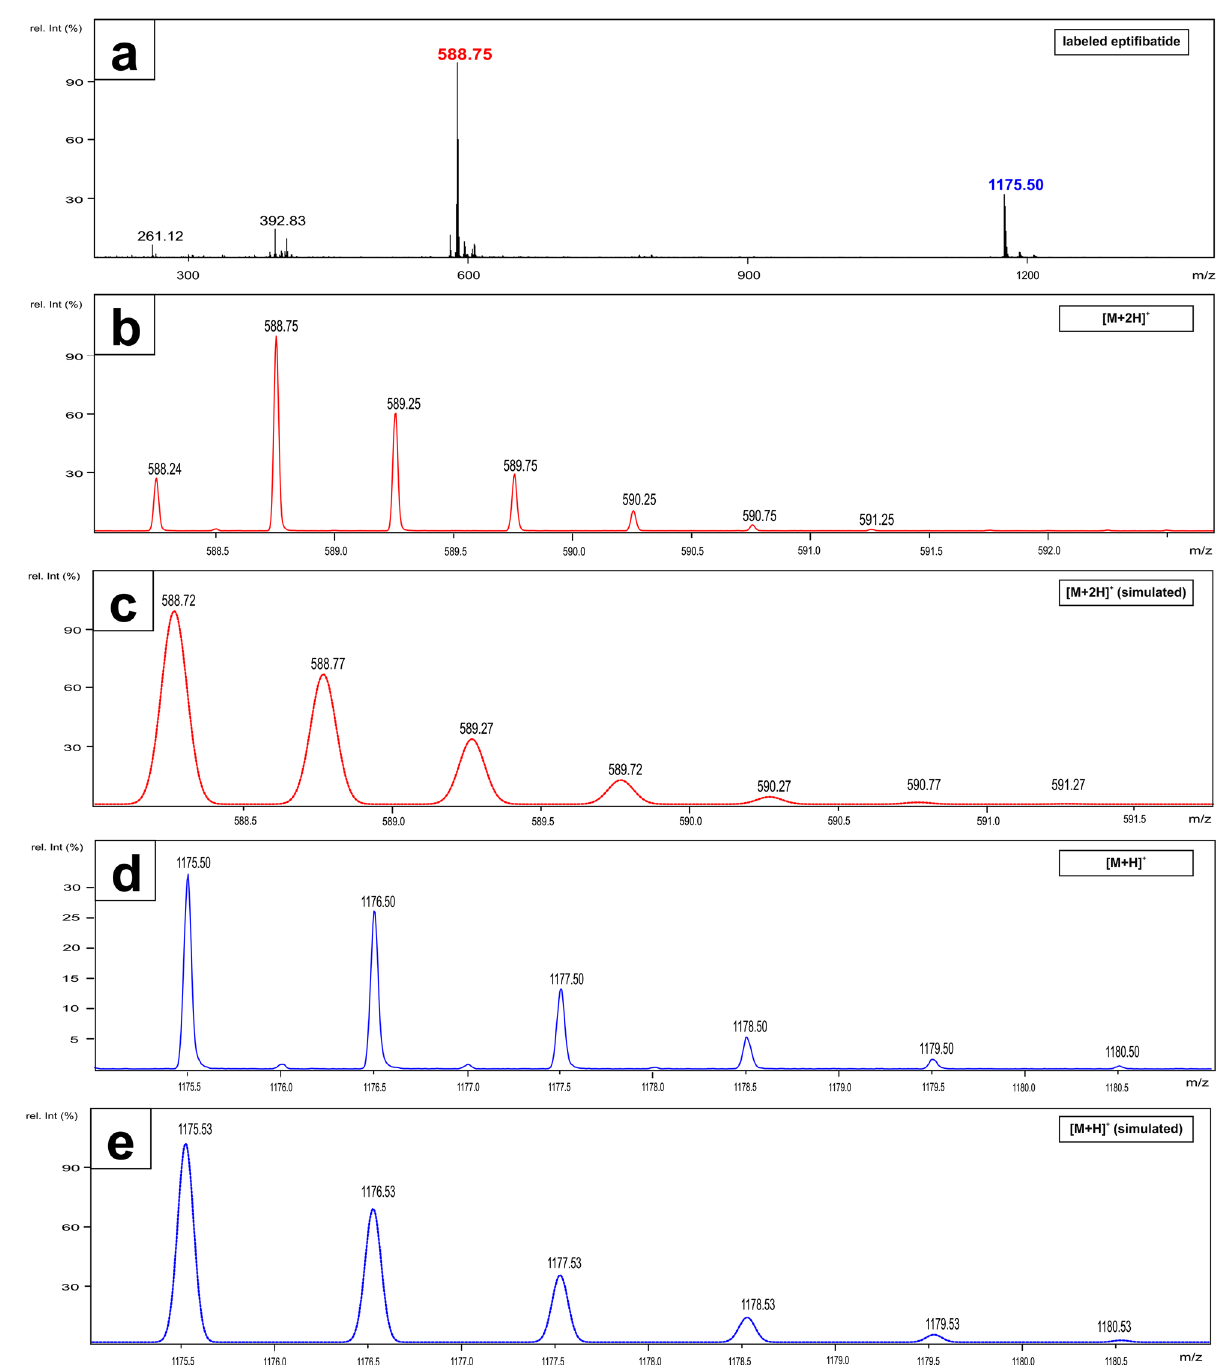
Figure 2. (a) ESI–MS of 3 displaying the [M + 2H] 2+ and the [M + H] + peaks. (b) Expansion of the [M + 2H] 2+ peak (experimental). (c) Simulation of the [M + 2H] 2+ peak. (d) Expanded experimental [M + H] + peak. (e) Simulation of the [M + H] +